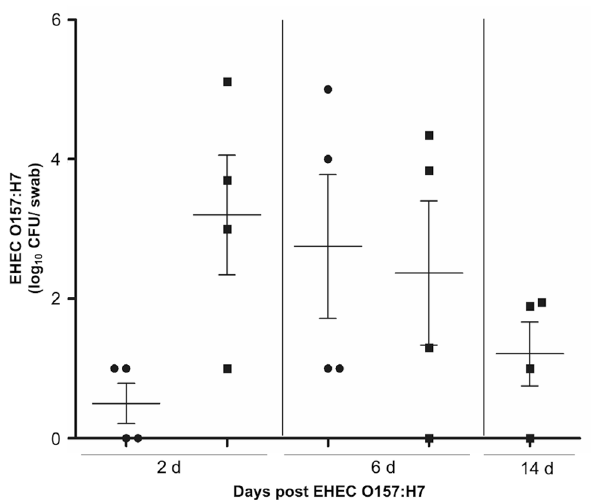
Figure 1. Fecal shedding of EHEC O157: H7 after experimental infection of calves. Circles indicate calves terminated at 7 d post-challenge (Group 1) and squares indicate calves terminated at 14 d post-challenge (Group